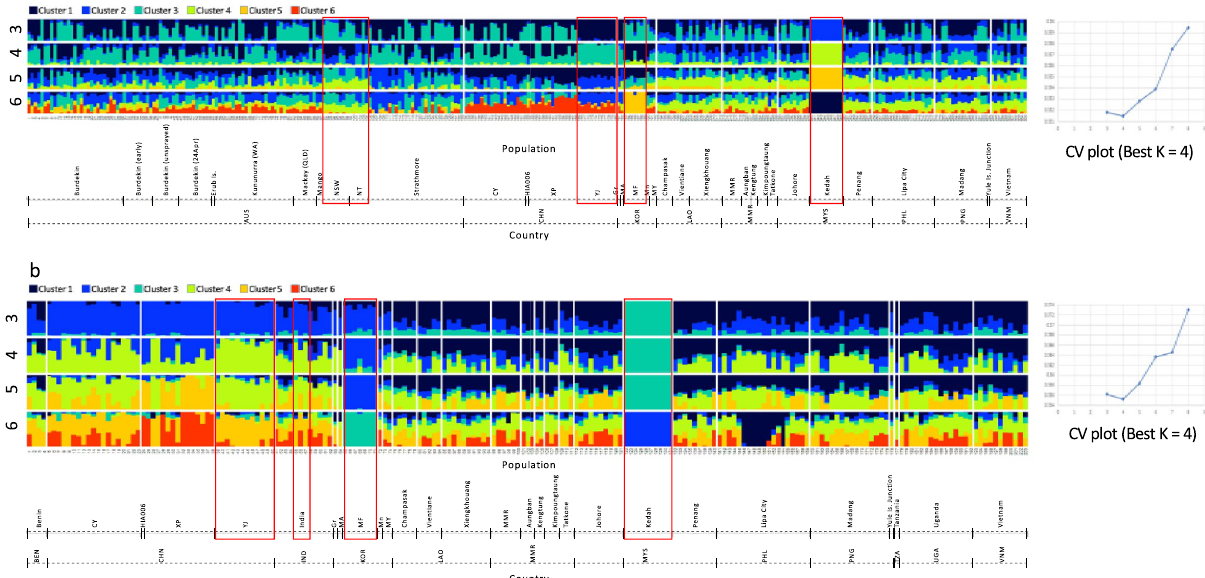
Figure 5. Admixture and corresponding CV plots for FAW populations from: ( a ) Australia, China, South Korea, Lao PDR, Myanmar, Malaysia, Philippines, PNG, and Vietnam, and ( b ) Benin, China, India, South Korea, Lao PDR, Myanmar, Malaysia, Philippines, PNG, Tanzania, and Vietnam. Optimal ancestral genetic clusters are K = 4 for both admixture plots. Boxed individuals have unique admixture patterns at K = 4 when compared with other populations. China FAW lacked Cluster 2 (navy blue colour; present in almost all SEA and Australian FAW), while in NSW and NT some individuals lacked cluster 3. South Korea ‘MF’